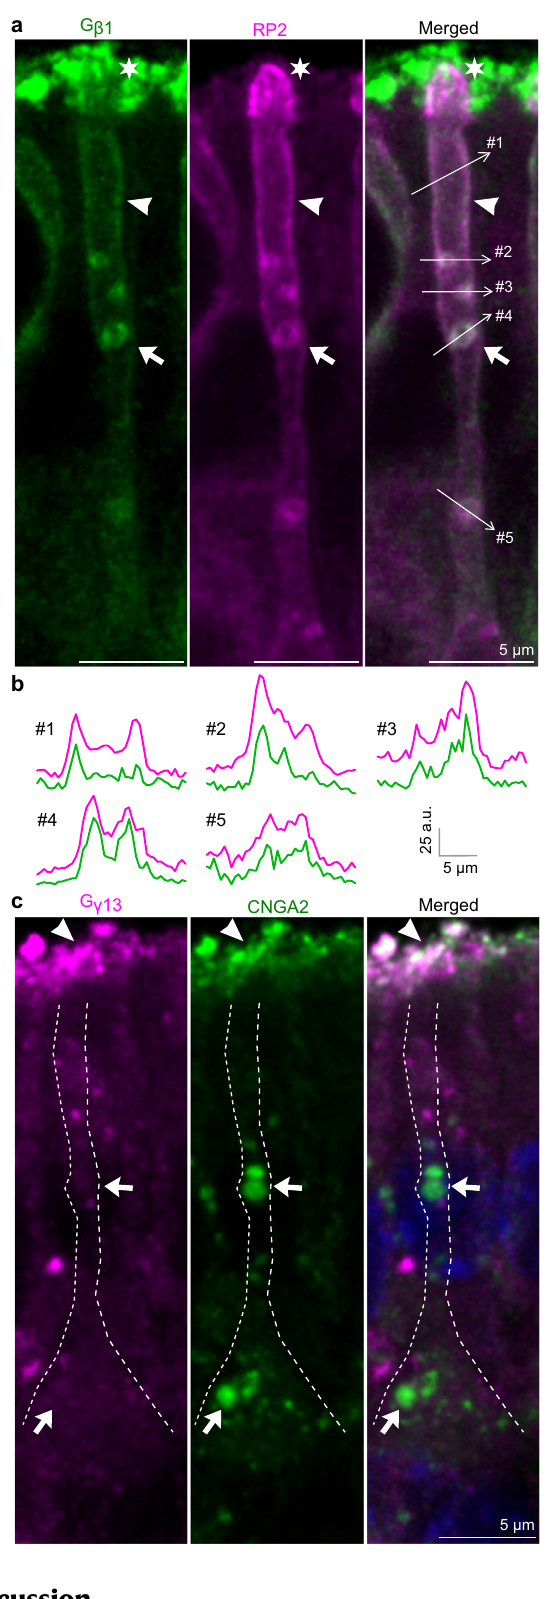
Fig.6|G β 1/RP2colocalizationandMVT-independentG γ 13traf fi cking.a Double immunohistochemistry showing G β 1/RP2 colocalization in the limiting membrane (arrow),plasmamembrane(arrowhead)anddendriticknob(asterisk). b Linescans of the plasma and limiting membranes showing a high degree of overlap between G β 1 (green) and RP2 (magenta) immuno fl uorescence in areas of the dendrite that are indicated in ( a ) (#1 – 5). c Double CNGA2 (green)/G γ 13 (magenta) immunohis- tochemistry showing that G γ 13 and CNGA2 were colocalized in cilia (arrowhead) but not in the soma or dendrites (arrows). Representative images are shown (2 mice, >30